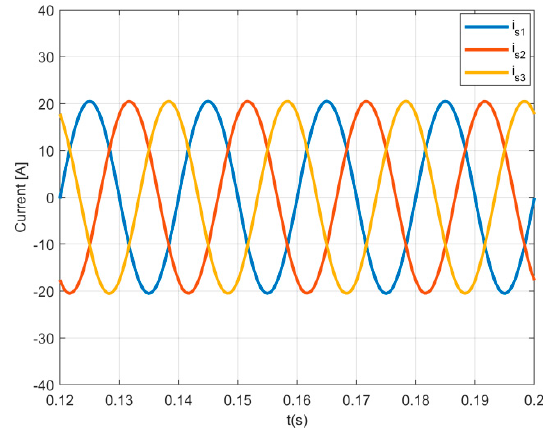
Figure 5. Results of the three-phase charger input currents.